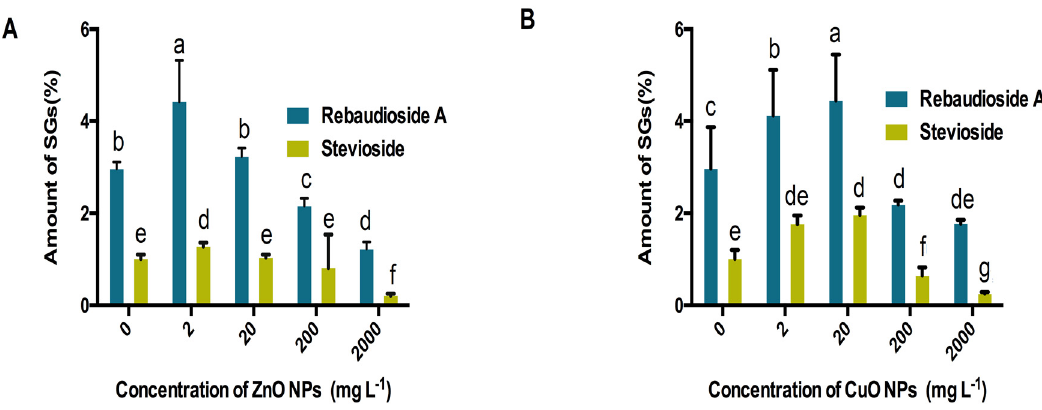
Figure 3. ( A ) Effect of ZnO ENPs and ( B ) effect of CuO ENPs at different concentrations ranging between 0 and 2000 mg/L on rebaudioside A content represented with blue bars and stevioside content indicated with yellow bars. Different letters indicate differences according to the Duncan’s multiple range test ( p < 0.05).